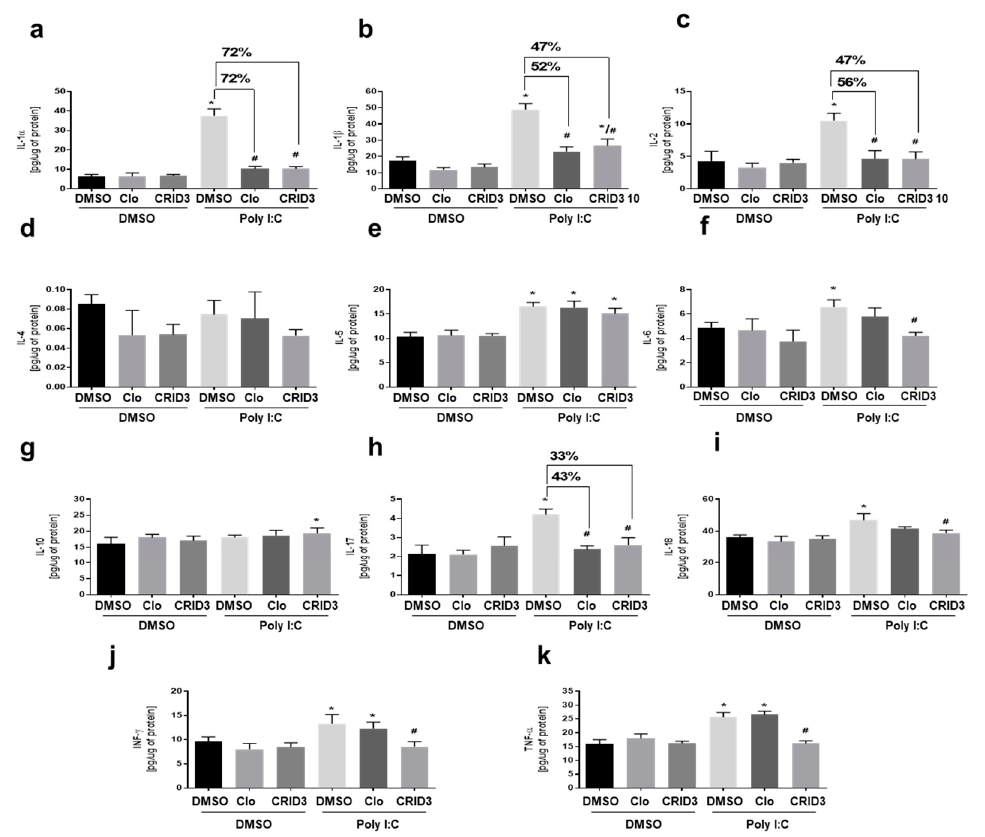
Figure 4. The e ff ect of clozapine and CRID3 on poly (I:C) induced cytokine levels: The e ff ects of 10 µ M clozapine and 10 µ M CRID3 on the expression of ( a ) IL-1 α , ( b ) IL-1 β , ( c ) IL-2, ( d ) IL-4, ( e ) IL-5, ( f ) IL-6, ( g ) IL-10, ( h ) IL-17, ( i ) IL-18, ( j ) INF- γ , and ( k ) TNF- α cytokines in poly (I:C)-stimulated microglia. The microglia were exposed to poly (I:C) (10 µ g / mL) and then immediately treated with clozapine (10 µ M) and CRID3 (10 µ M) for 24 h. The experiments were performed with each sample in triplicate. clozapine (CLO). The data is expressed as the mean ± SD of three independent experiments. * p < 0.05 vs. control samples. # p < 0.05 vs. poly (I:C)-treated samples.